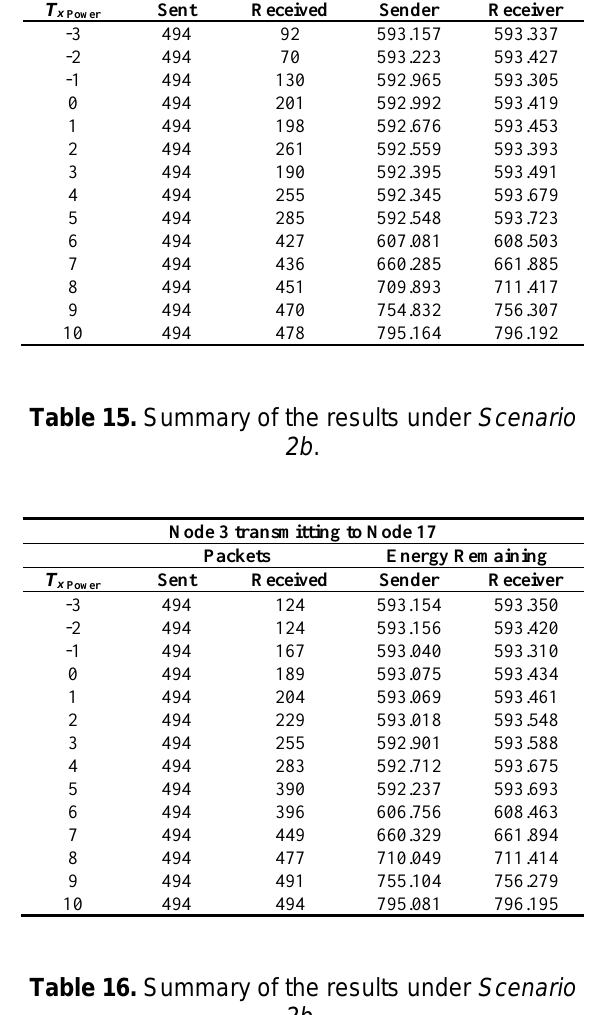
Table 16. Summary of the results under Scenario 2b .